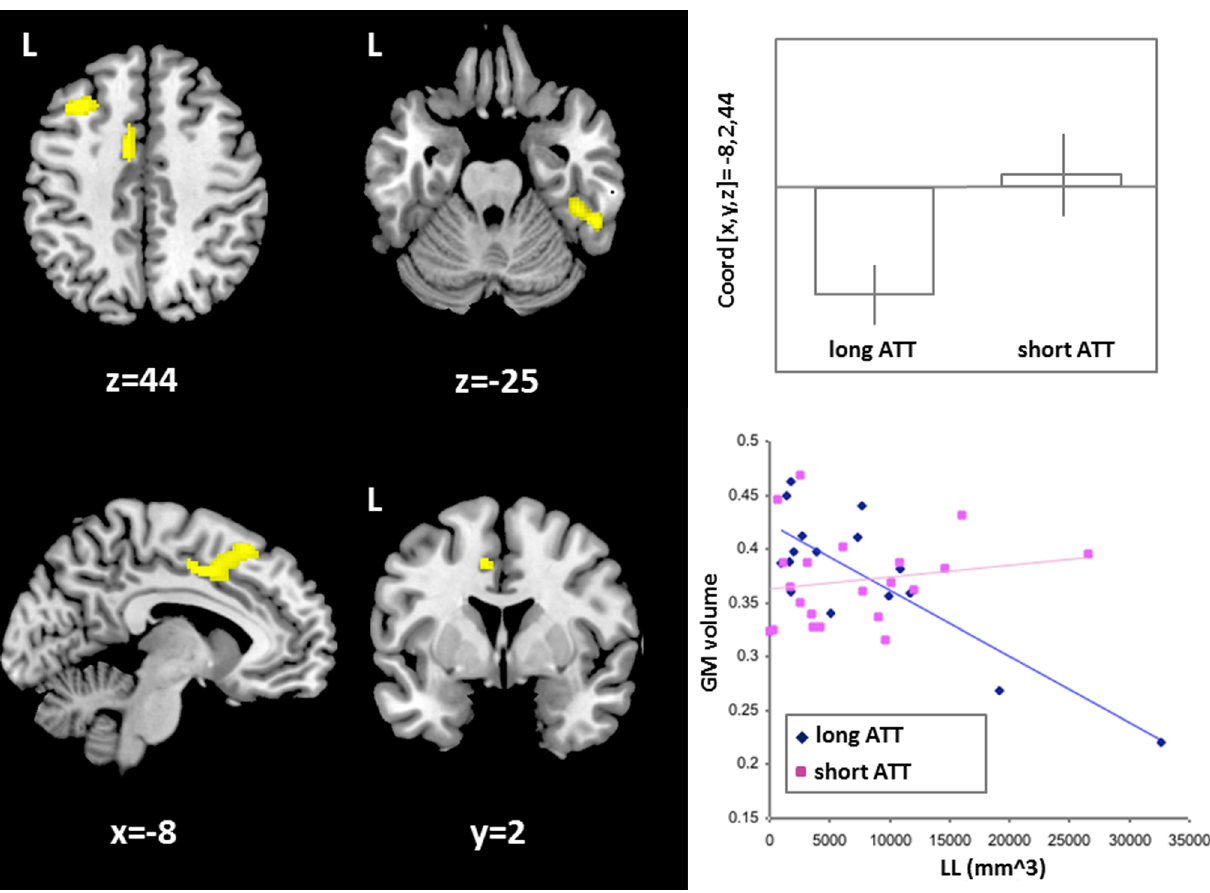
Figure 4. Interaction between the CNR1 genotype and T2-weighted lesion loads on regional GM volumes. In yellow, there are shown those areas (i.e., left frontal and cingulate cortex, and right temporal cortex) in which an inverse correlation exists between T2-lesion load and local grey matter volumes in individuals with long AAT repeats, but that is absent in those with short AAT repeats. The plot on the top right shows this effect of interaction in the left frontal and cingulate area. This same effect is also confirmed, on a subject by subject basis, by the sctatterplot on the bottom right. Statistical threshold: p values FWE-corrected , 0.05. Spatial coordinates (x,y,z) in the figure are in MNI space. Abbreviations: LL= T2-weighted lesion load; GM=grey matter. Fig. 5H; SDMT: r= 0.02, p =0.86; Spatial Recall Test [SPART]: r= 0.05, p =0.61; Selective Reminding Test [SRT]: r= 2 0.002, p = 0.97).